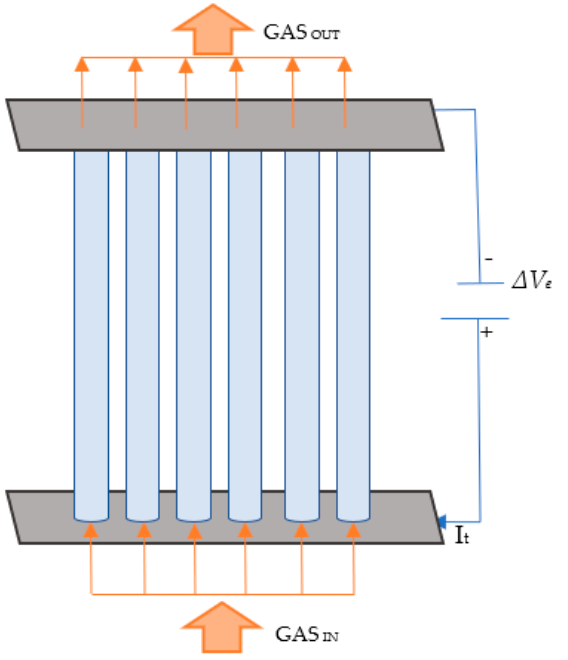
Figure 7. Parallel tube reactor configuration. Adapted from [105].